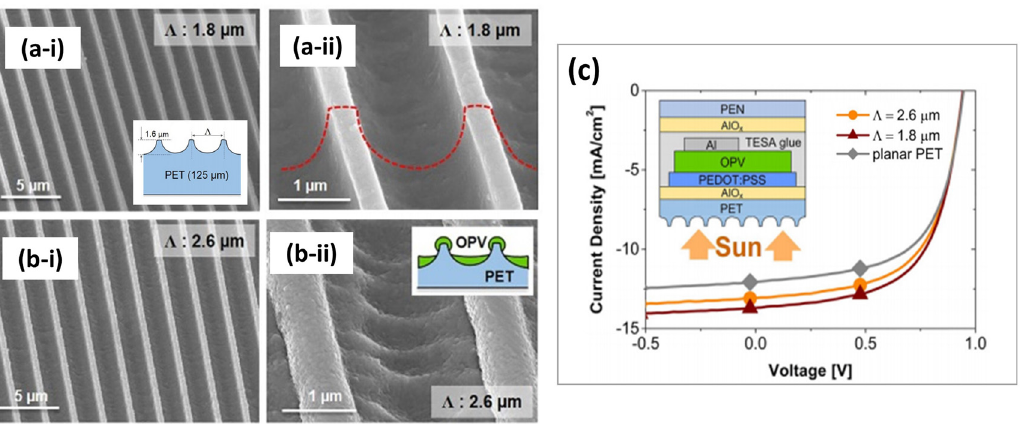
Figure 4: (a) and(b) SEM images of microstructuredPET-DLIP(a-i) to (a-ii) with 1.8µm period,(b-i)with 2.6µm periodwo/OPVmultilayer,and (b-ii) with 2.6 µm period with OPV multilayer. In fi gures (a-i) y (b-i) the schematic patterning PET and PET-OPV is shown; (c) Current-potential curve for planar PET-OPV and DLIP PET-OPV at different periods, top left OPV multilayer scheme. Reproduced from ref. [82] (Licensed under a Creative Commons Attribution).